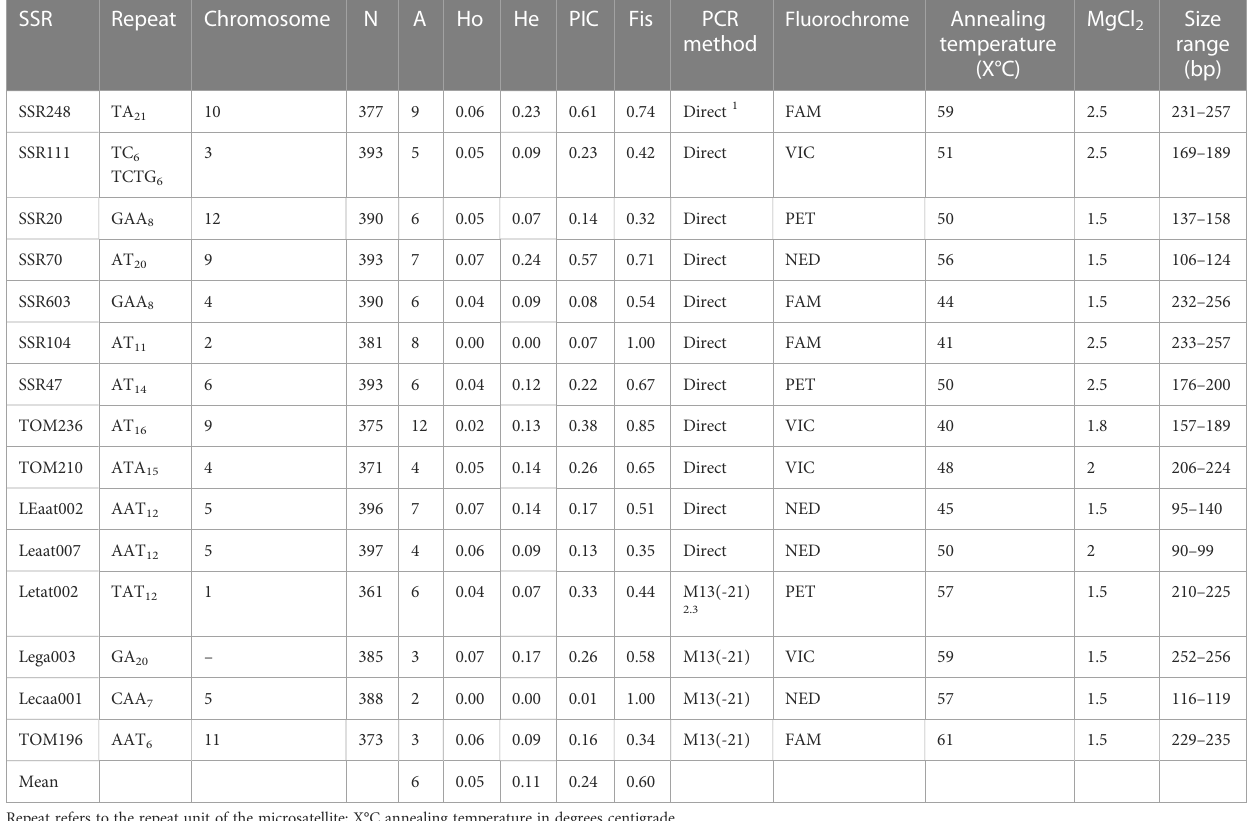
TABLE 2 Characteristics and ampli fi cation conditions of the microsatellites used in this